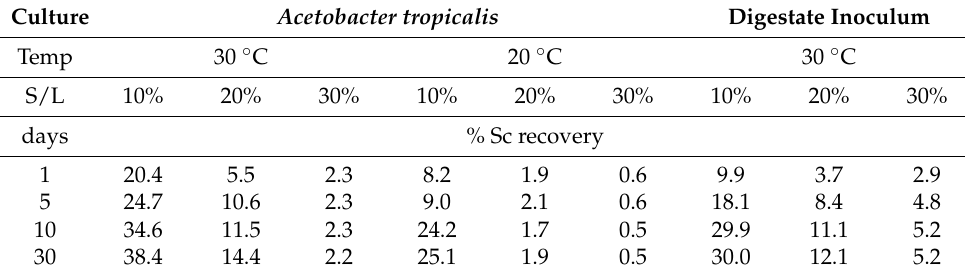
Table 1. Sc recovery over time for different culture solutions.